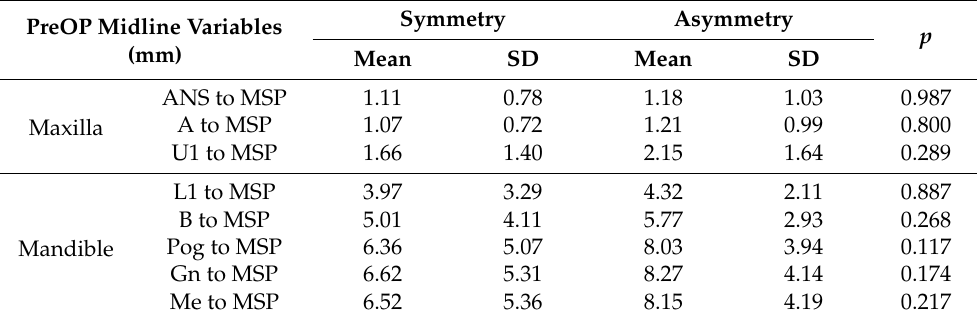
Table 3. Comparison of 3D preoperative (T0) measurements of midline variables between groups S and A.